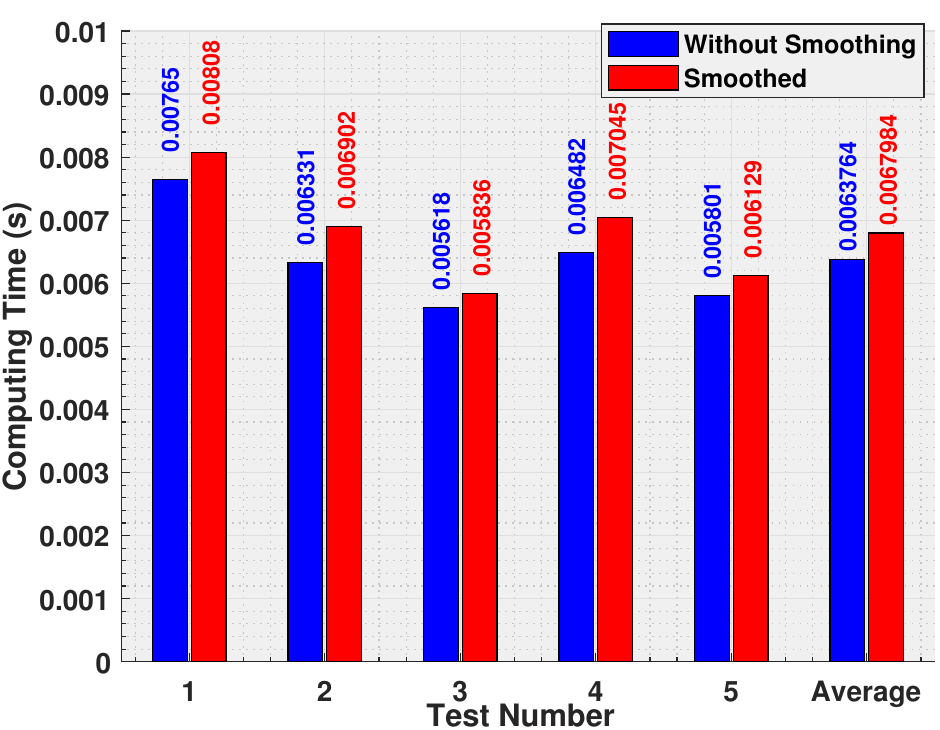
Figure 8. Comparison of the computation time used for the generation of original and smoothed trajectories in 2D for a swarm of 5